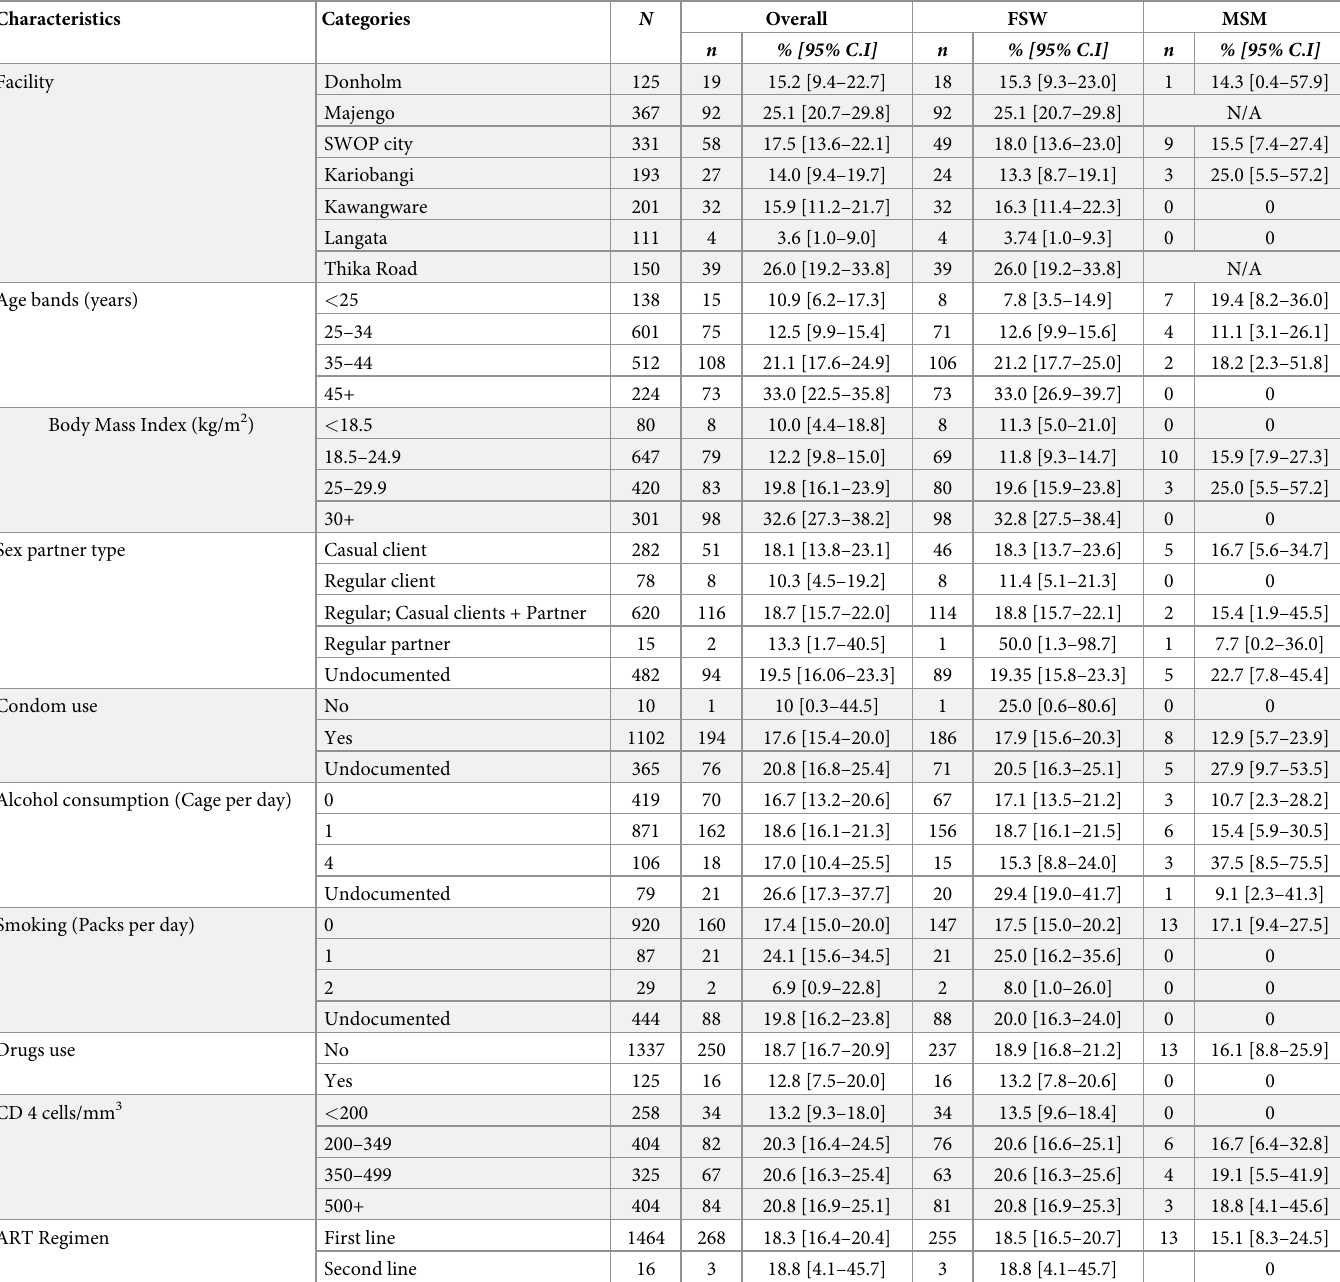
Table 2. Prevalence of Non-Communicable Diseases (NCDs) among key populations living with HIV by selected characteristics at SWOP clinics, 2012–2015.